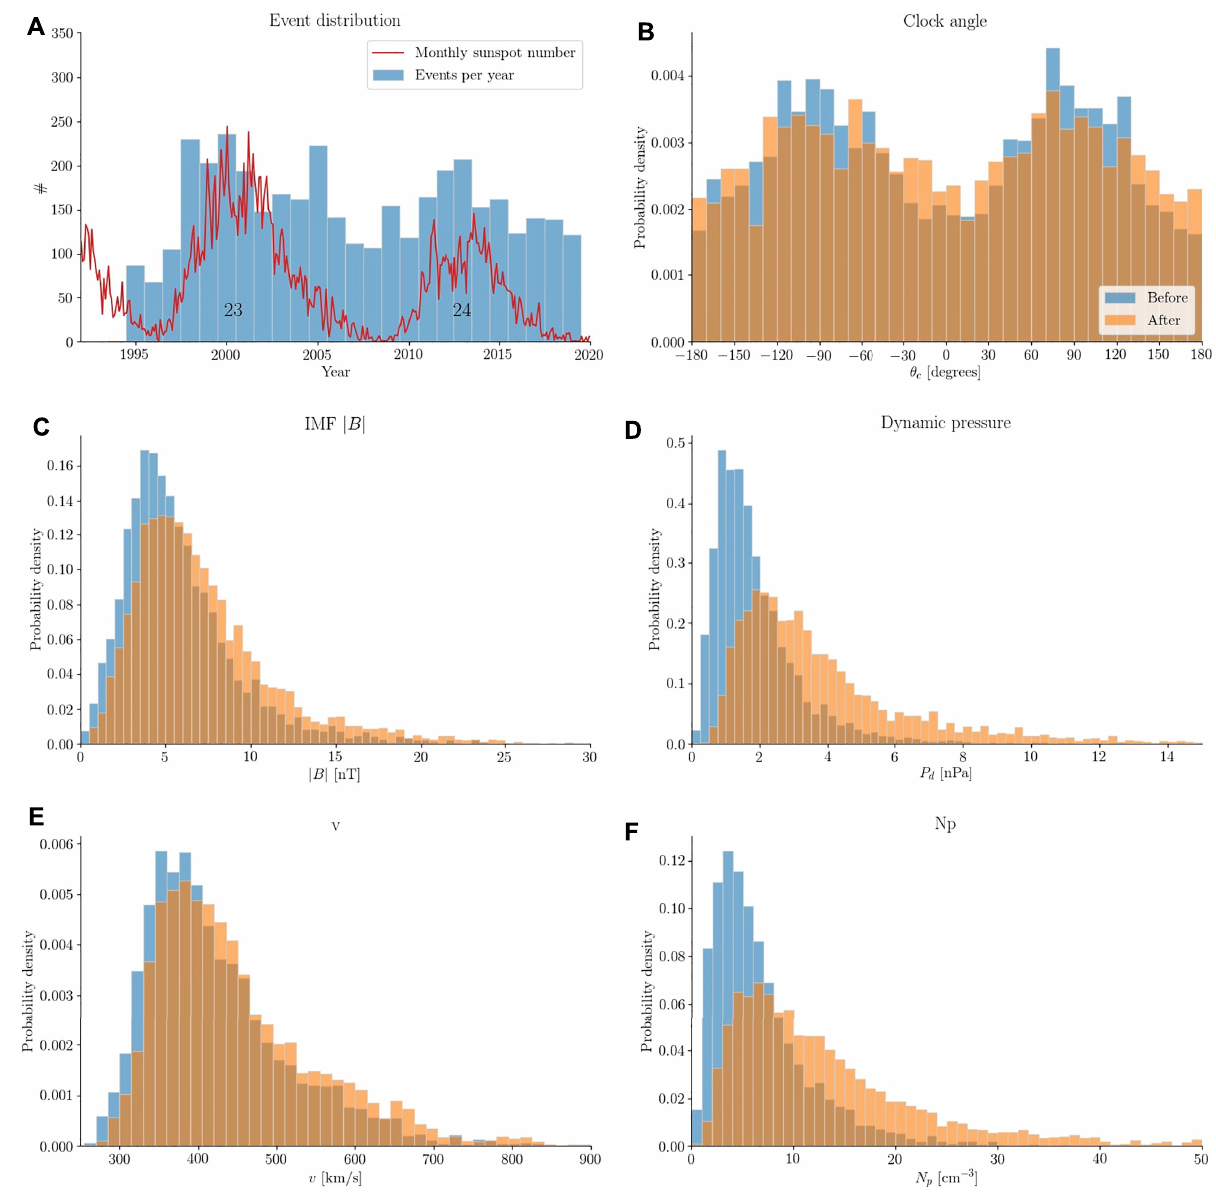
FIGURE 6 | Summary of statistics related to the event list. (A) shows the number of events detected for individual years along with the monthly sunspot number. (B–F) show statistics of the upstream (orange) and downstream (blue) IMF clock angle, IMF magnitude, solar wind dynamic pressure, solar wind bulk velocity and ion number